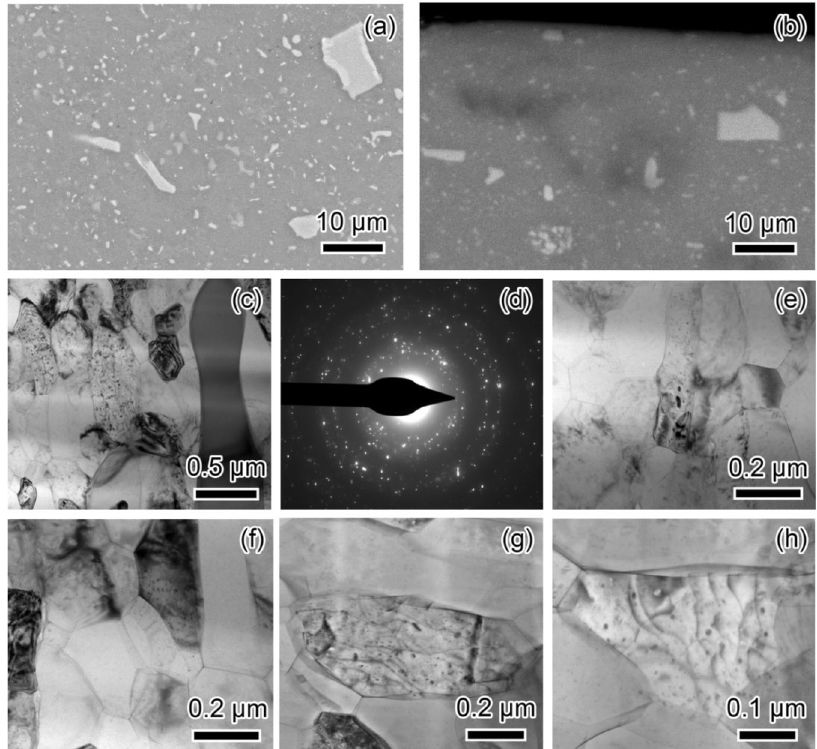
Fig. 3 Microstructures of Al – Mn alloys. Cross-sectional SEM images of GG sample ~2 mm away from ( a ) and adjacent to ( b ) the treated surface. c – h STEM-BF images and the corresponding diffraction pattern of GG sample within 10 μ m away from the treated surface. Diffraction pattern in ( d ) corresponds with the area shown in ( c ). Grains with sizes below 100 nm can be seen from ( e ) and ( f ), high density dislocations inside the ultra fi ne grains are shown in ( g ) and ( h